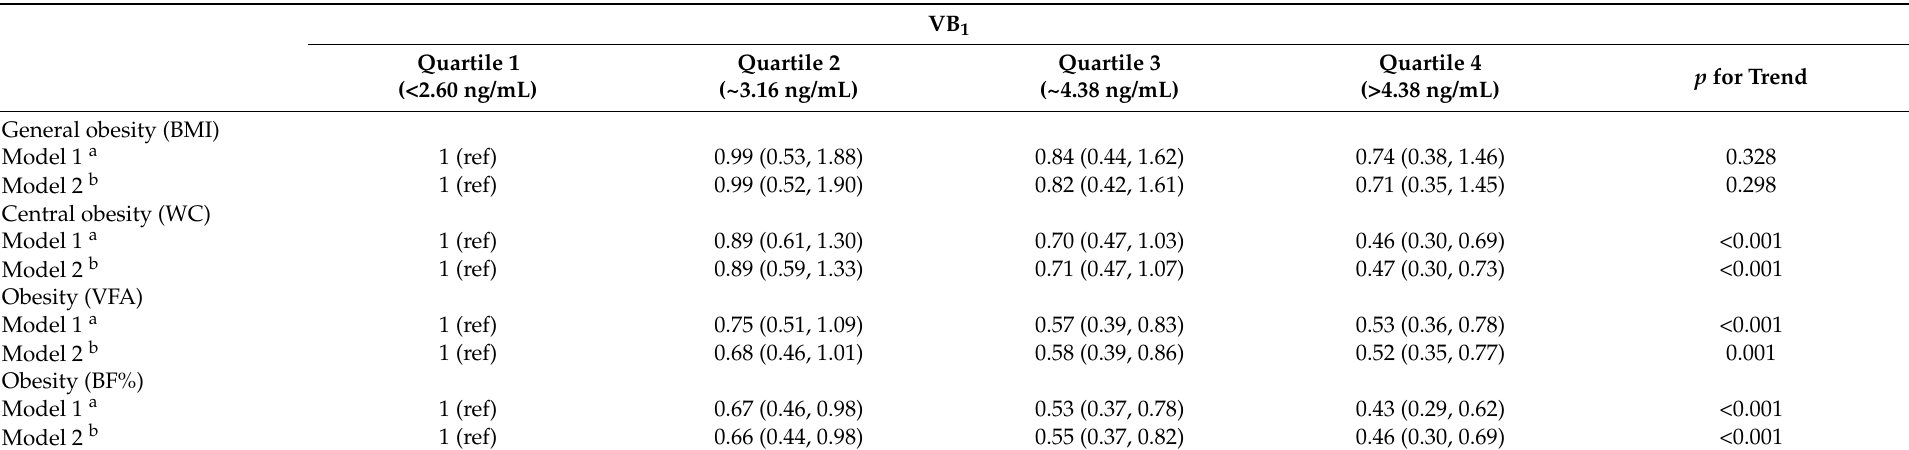
Table 4. Association between vitamin B 1 and obesity according to different obesity